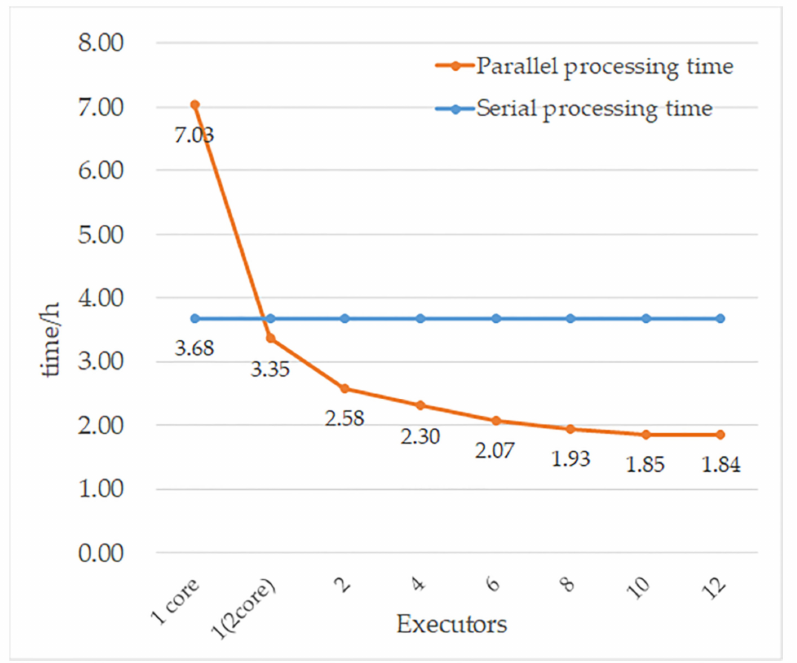
Figure 13. Comparison of filtering processing time with increasing number of executors for the entire study area (all PATCHs): the x -axis represents the number of executors, where the first value indicates that one executor is started in the case of a single core and the remaining values all start 2 cores. the y -axis represents the filtering processing.